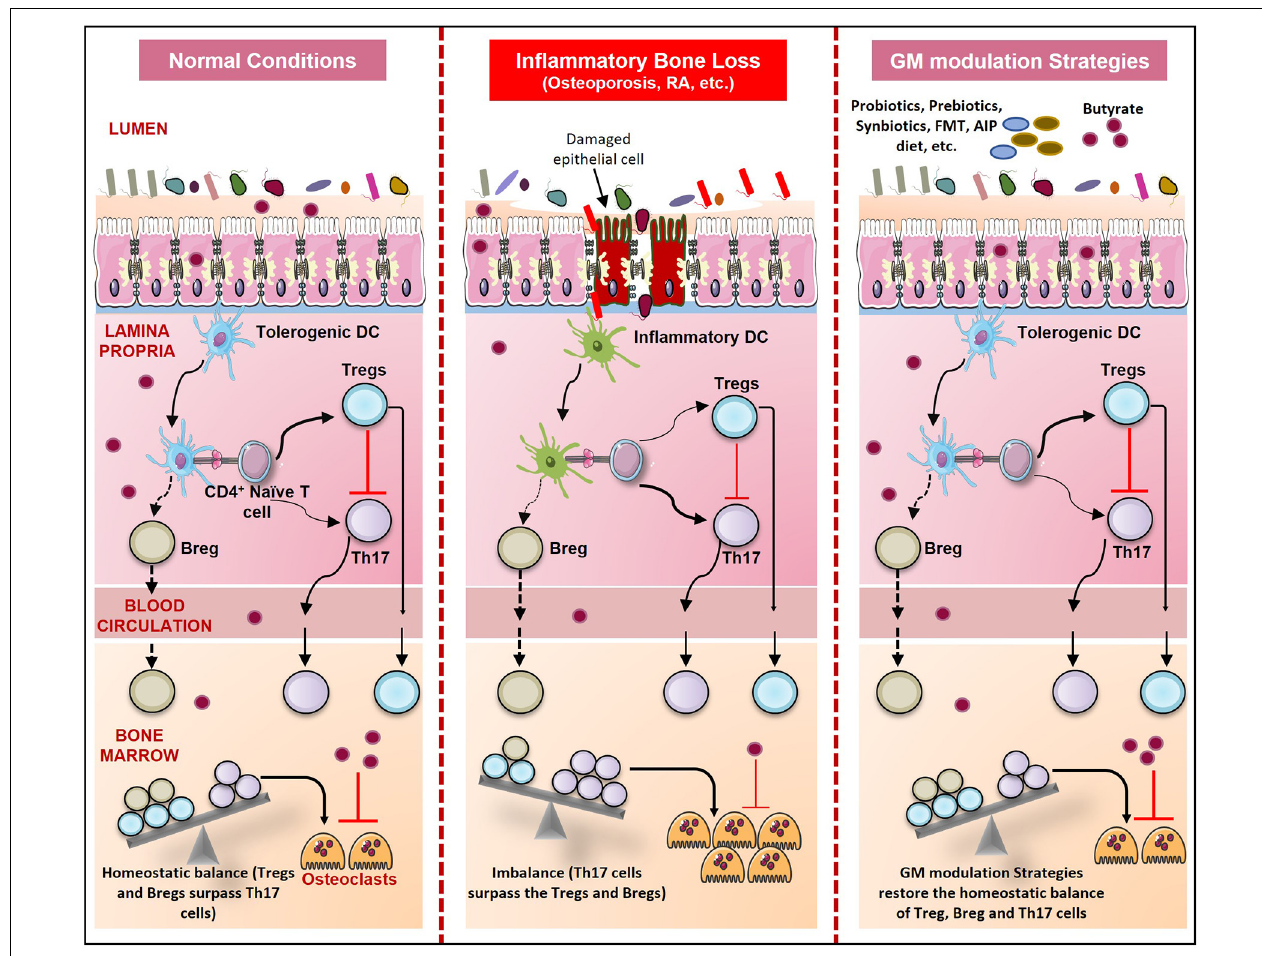
FIGURE 7 | GM modulation Strategies and Skeletal Health. During normal conditions, immune homeostasis is maintained. But in bone pathologies like osteoporosis, RA, and periodontitis due to dysbiosis, gut permeability increases resulting in an increase in the number of inflammatory Th17 cells. These Th17 cells outcompete the regulatory Tregs and Bregs which result in enhanced osteoclastogenesis and thus bone loss. Probiotics, prebiotics, synbiotics, postbiotics, FMT, Orthogonal niche engineering, autoimmune protocol diet (AIP), and Personalized GM modulation strategies prevent dysbiosis and restore the homeostatic balance of immune and bone